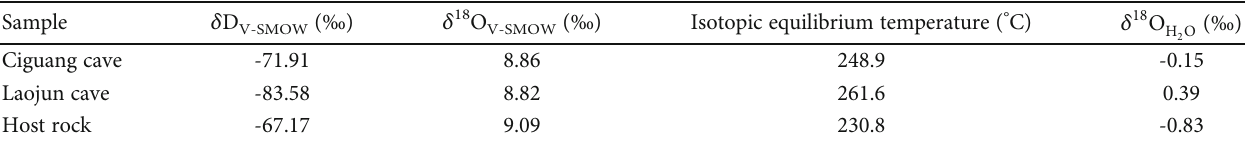
Table 3: H – O isotopic composition of quartz and fl uids in Laoshan